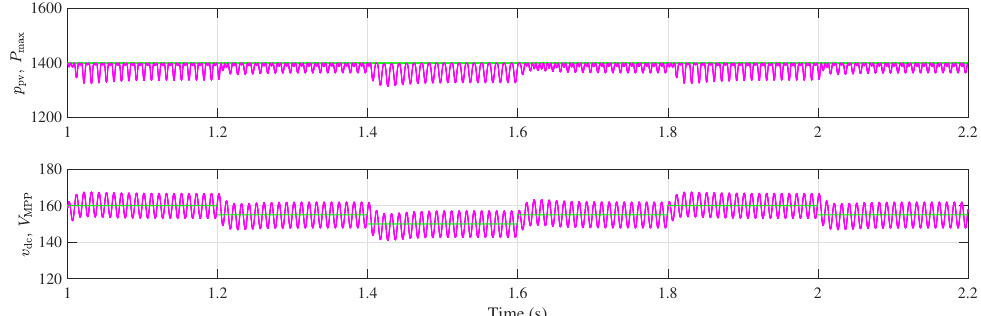
Figure 2. Time-domain waveforms of the sampled extracted power p pv for S = 1000 W/m 2 in steady-state operation. V M = 3.2 V.